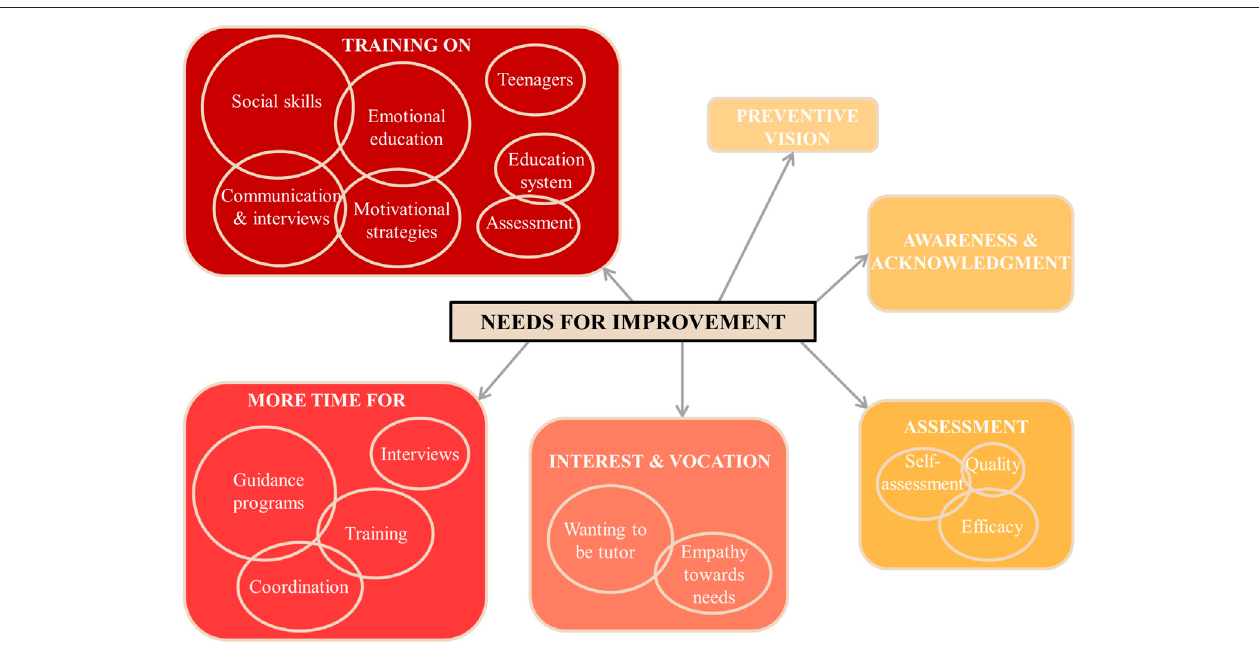
FIGURE 3 | Needs for improvement in the tutorial actions developed by